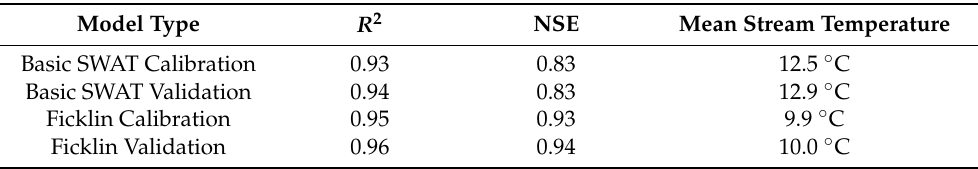
Table 4. Statistical results of the daily stream temperature calibration. The average recorded stream temperature at the USGS gauge is 7.8 ◦